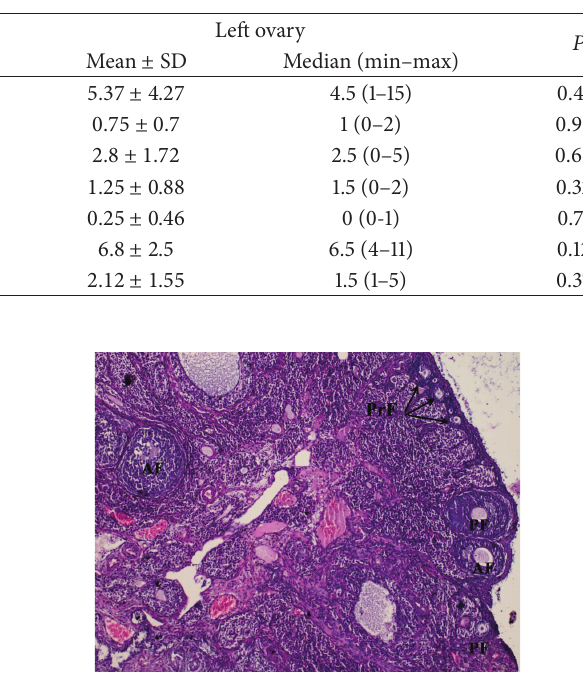
Figure 1: A slight decrease in primary follicles (PF) and antral follicles (AF) in right ovary sample, as well as an increase in theca interna cells in the more intensively observed cystic follicles (KF), atretic follicles (AtF), and ovarian stroma (arrows) (H&E × 40).